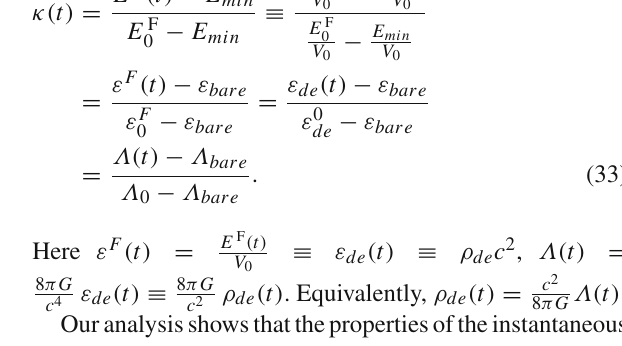
the energies and the decay rate: E (cid:20)→ ε = E Γ 0 , where V 0 = V ( t init V 0